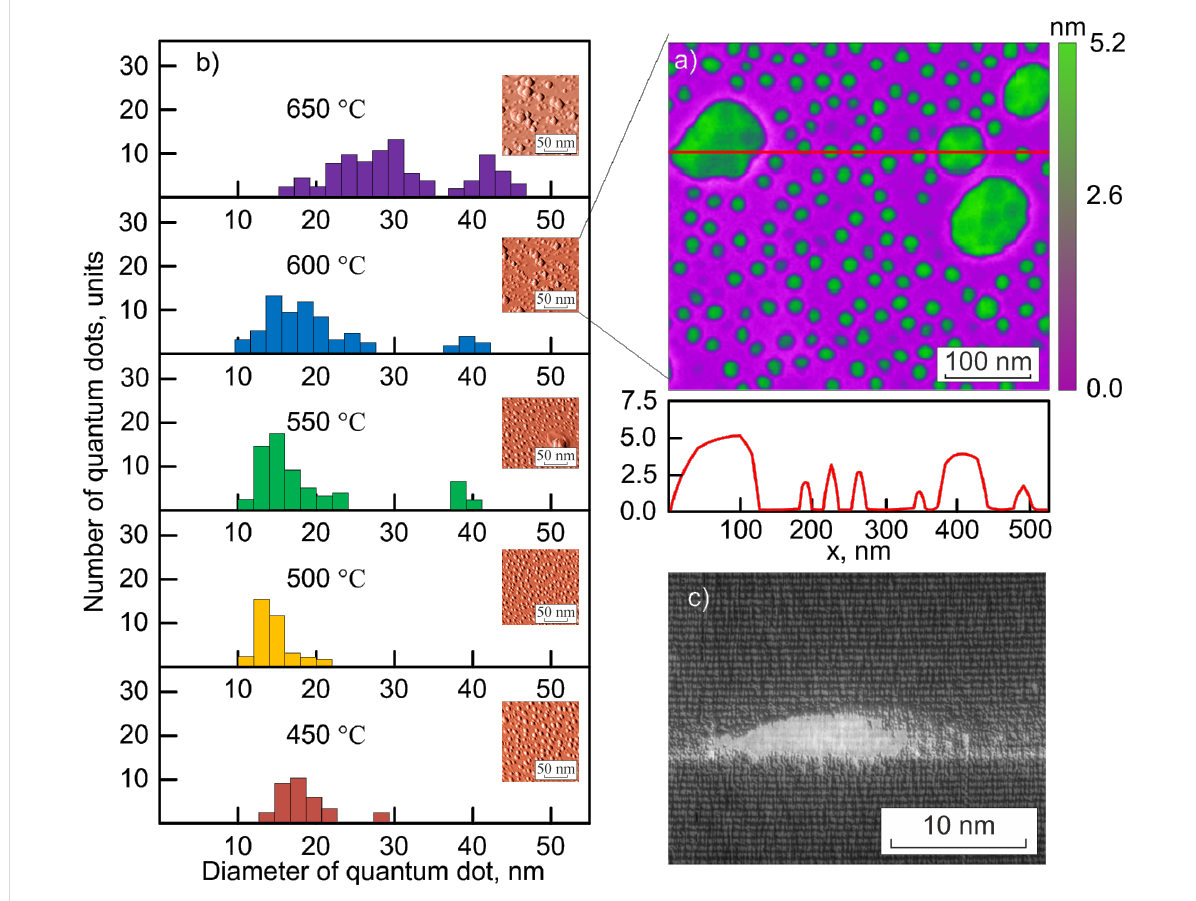
Figure 3: Size distribution of InAs quantum dots as a function of the substrate temperature.